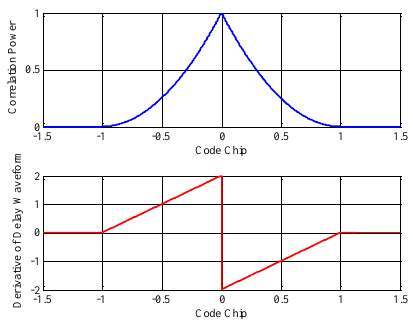
Figure 2. Delay waveform and its derivative of a GNSS signal reflected from a perfectly smooth sea surface.